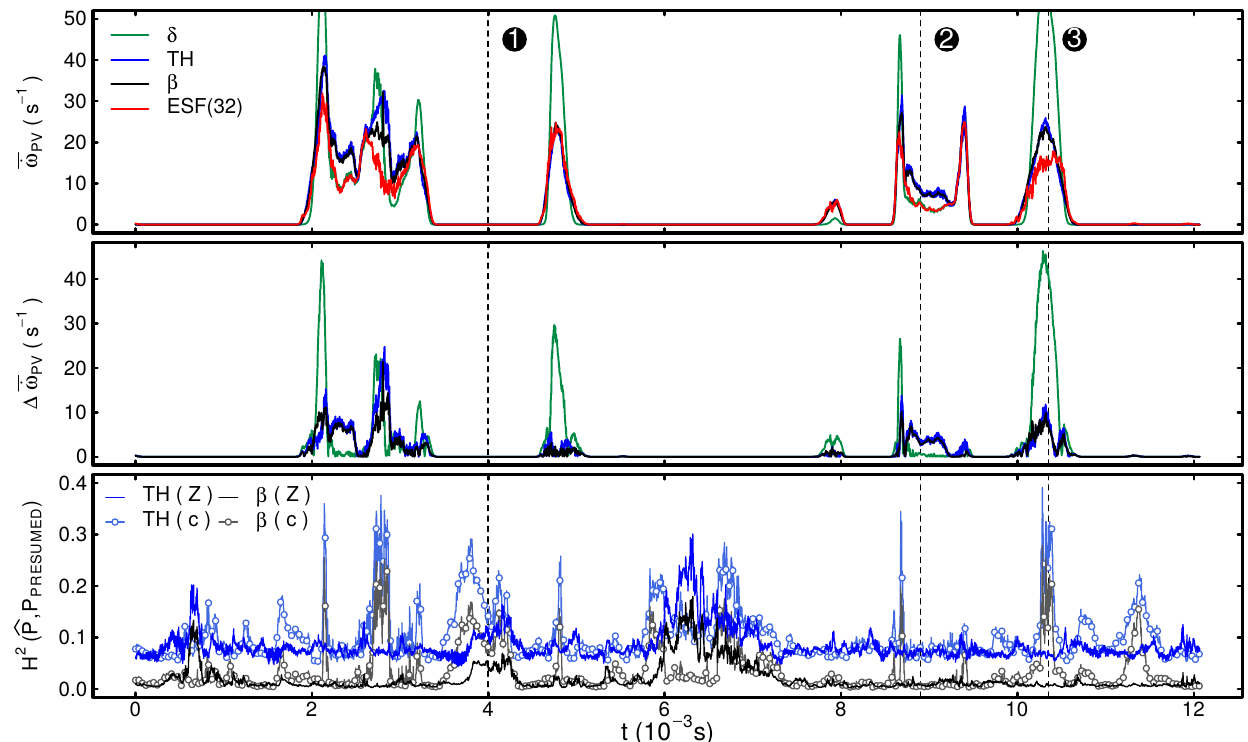
Figure 10. Top: Temporal evolution of the PDF-integrated progress variable source term ¯˙ ω PV at the location of Probe A for the ESF simulations alongside results obtained from three presumed PDF shapes. Center: Absolute difference between the presumed approaches and the ESF(32) simulation results. Bottom: Hellinger distance (see Appendix C) between the stochastic fields PDF and the presumed shapes. Vertical dotted lines: time instants corresponding to the time instant discussed